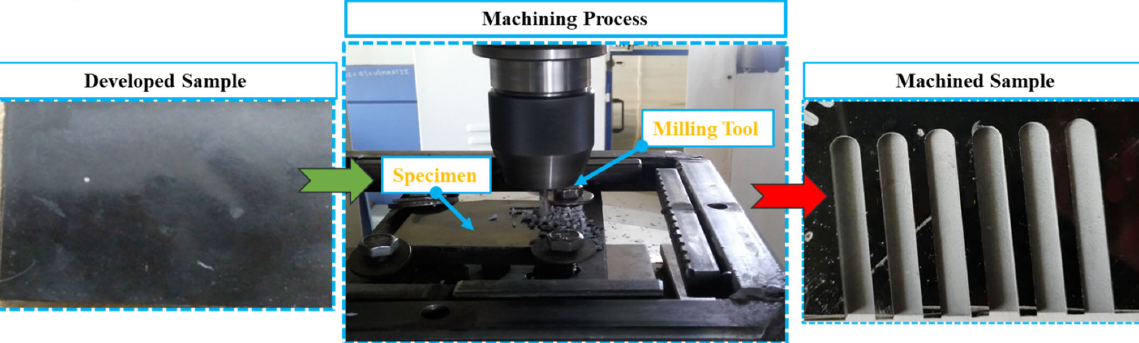
Fig. 2. Experimentation